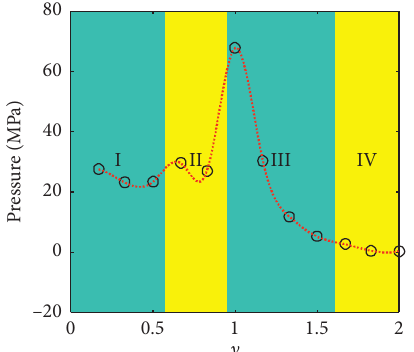
Figure 26: Pressure peak of wall pressure variation diagram in the second cycle for 0.17 ≤ c ≤